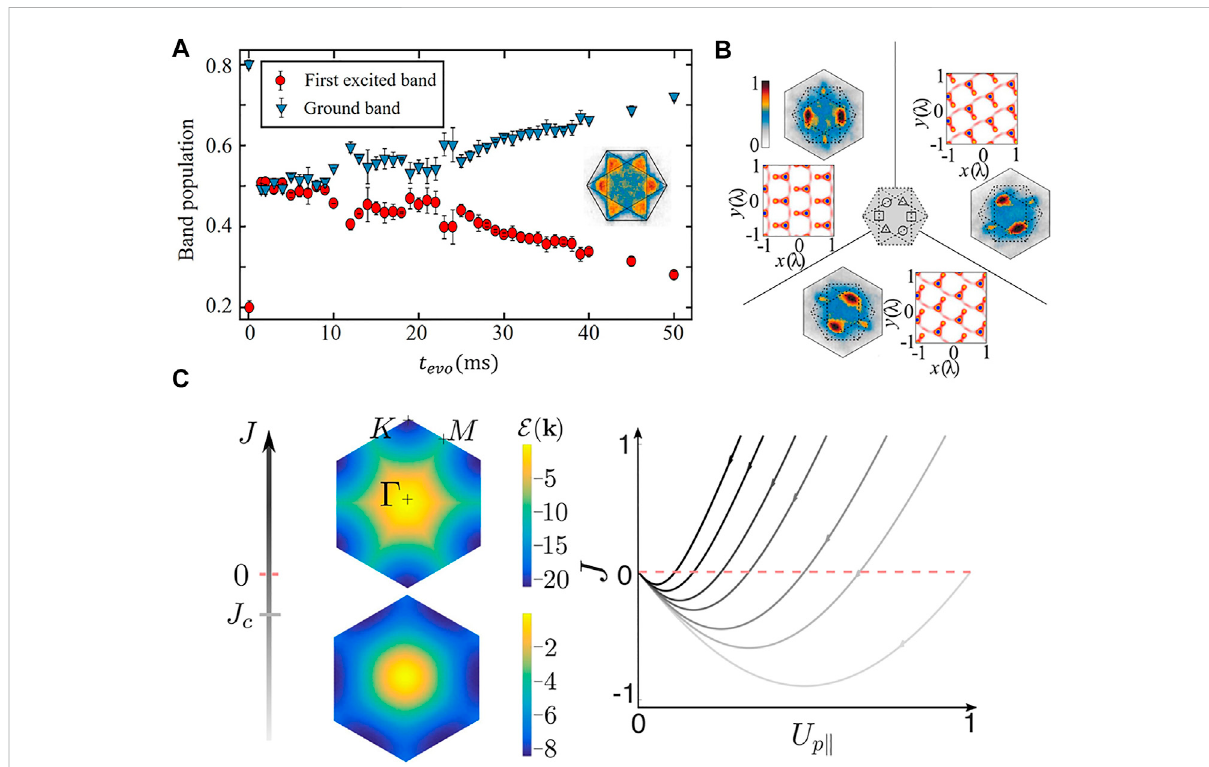
FIGURE 11 (A) Themeasuredtimeevolutionoftheatomicpopulationinthegroundandthesecondbandsofthehexagonalopticallattice. (B) Theaveraged momentum distribution for three symmetries. (C) Theoretical quantum phase transitions varying the orbital Josephson coupling. The energy ε ( k )for a plane-wave condensate at a lattice momentum k . The energy ε ( k ) has minima at K (M) points for J > J c ( J < J c ). The right fi gure is the sketch of the renormalization of the p-orbital couplings to low